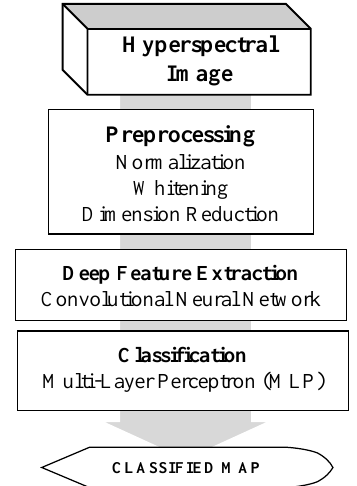
Figure 1. The proposed framework for classification of hyperspectral images.